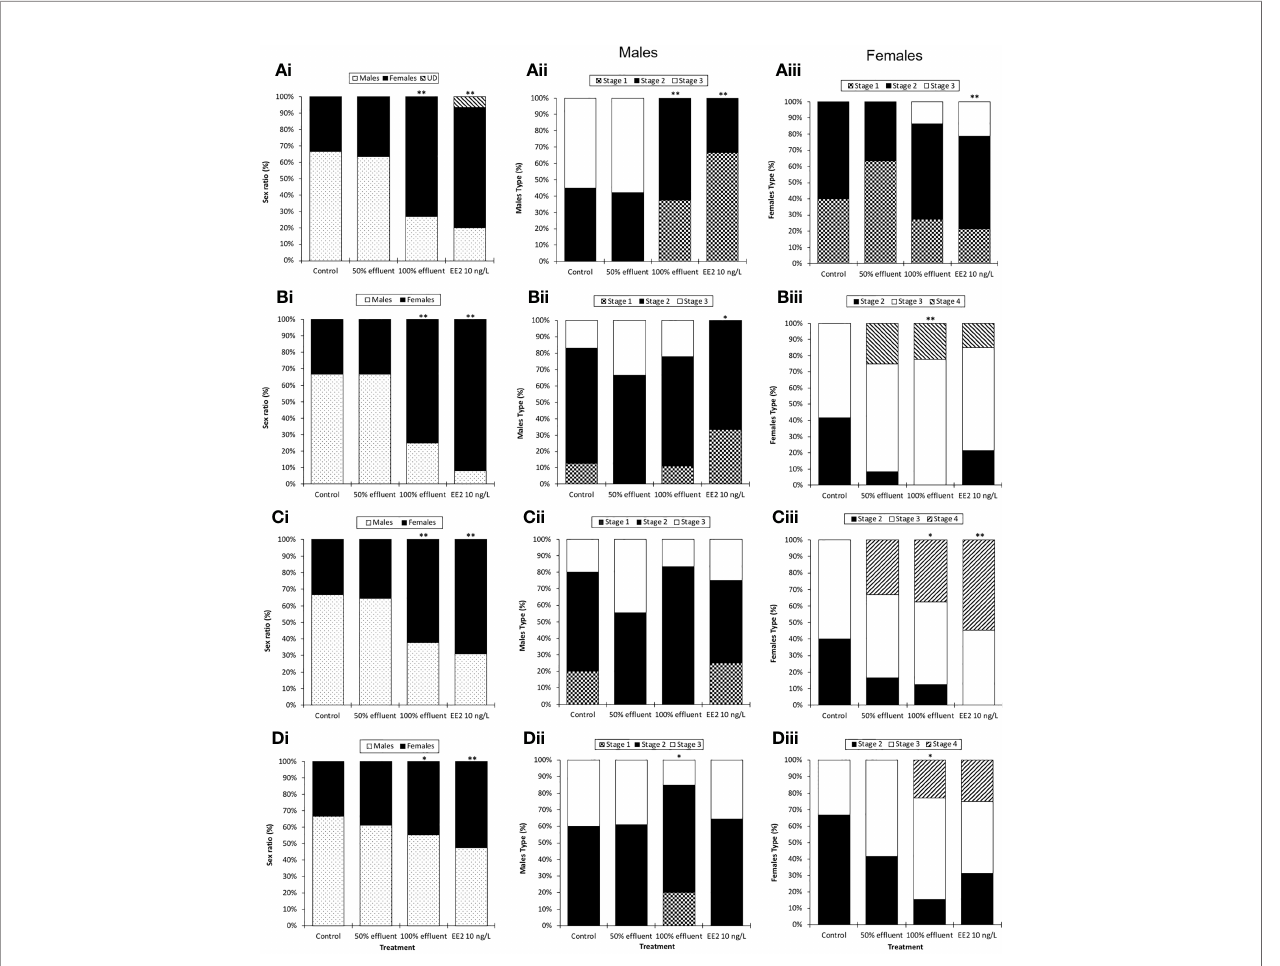
FIGURE 3 | Sex ratios and male and female maturity index in ERE-GFP Casper zebra fi sh. Sex and indices of sexual maturity were measured in transgenic zebra fi sh at 60 dpf or 90 dpf following exposure to EE2 (10 ng/L), a WwTW ef fl uent (at 100% or 50% dilution) or a dilution water control during the following developmental periods: (A) 0-90 days (data analysis at 60 dpf); (B) 0-90 days (data analysis at 90 dpf) (C) 21-60 days (data analysis at 60 dpf) and (D) 60-90 days (data analysis at 90 dpf). Data are reported as mean ± SE. Asterisks denote statistically signi fi cant differences (*p<0.05, **p<0.01) from expected sex/maturity index ratios according to a chi-square contingency